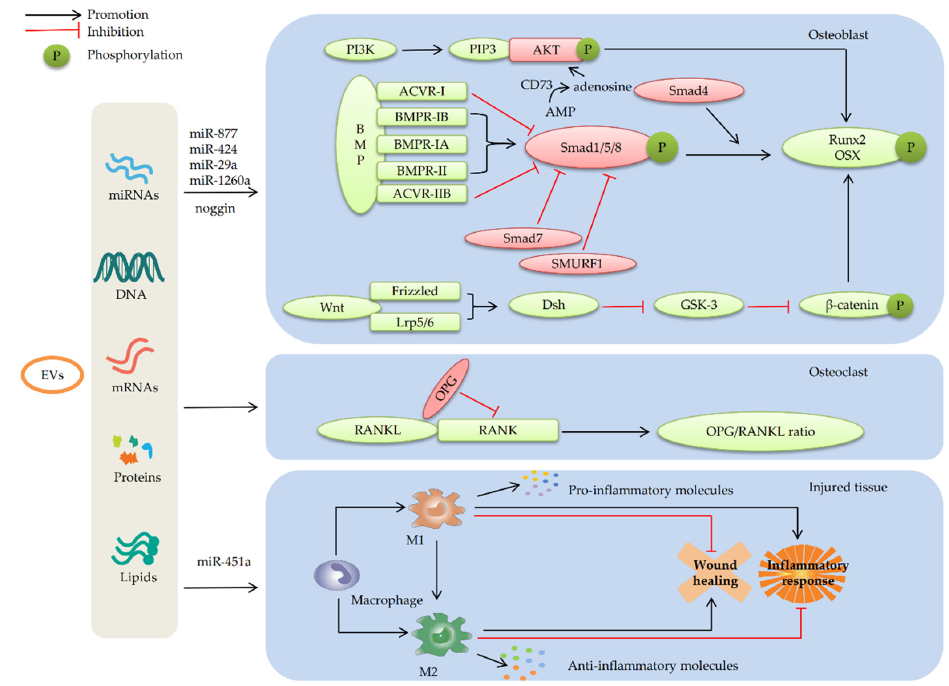
Figure 3. The main mechanism of EVs to improve the activity of osteoblasts, inhibit the activity of osteoclasts and reduce inflammation through the intrinsic cargo within EVs.